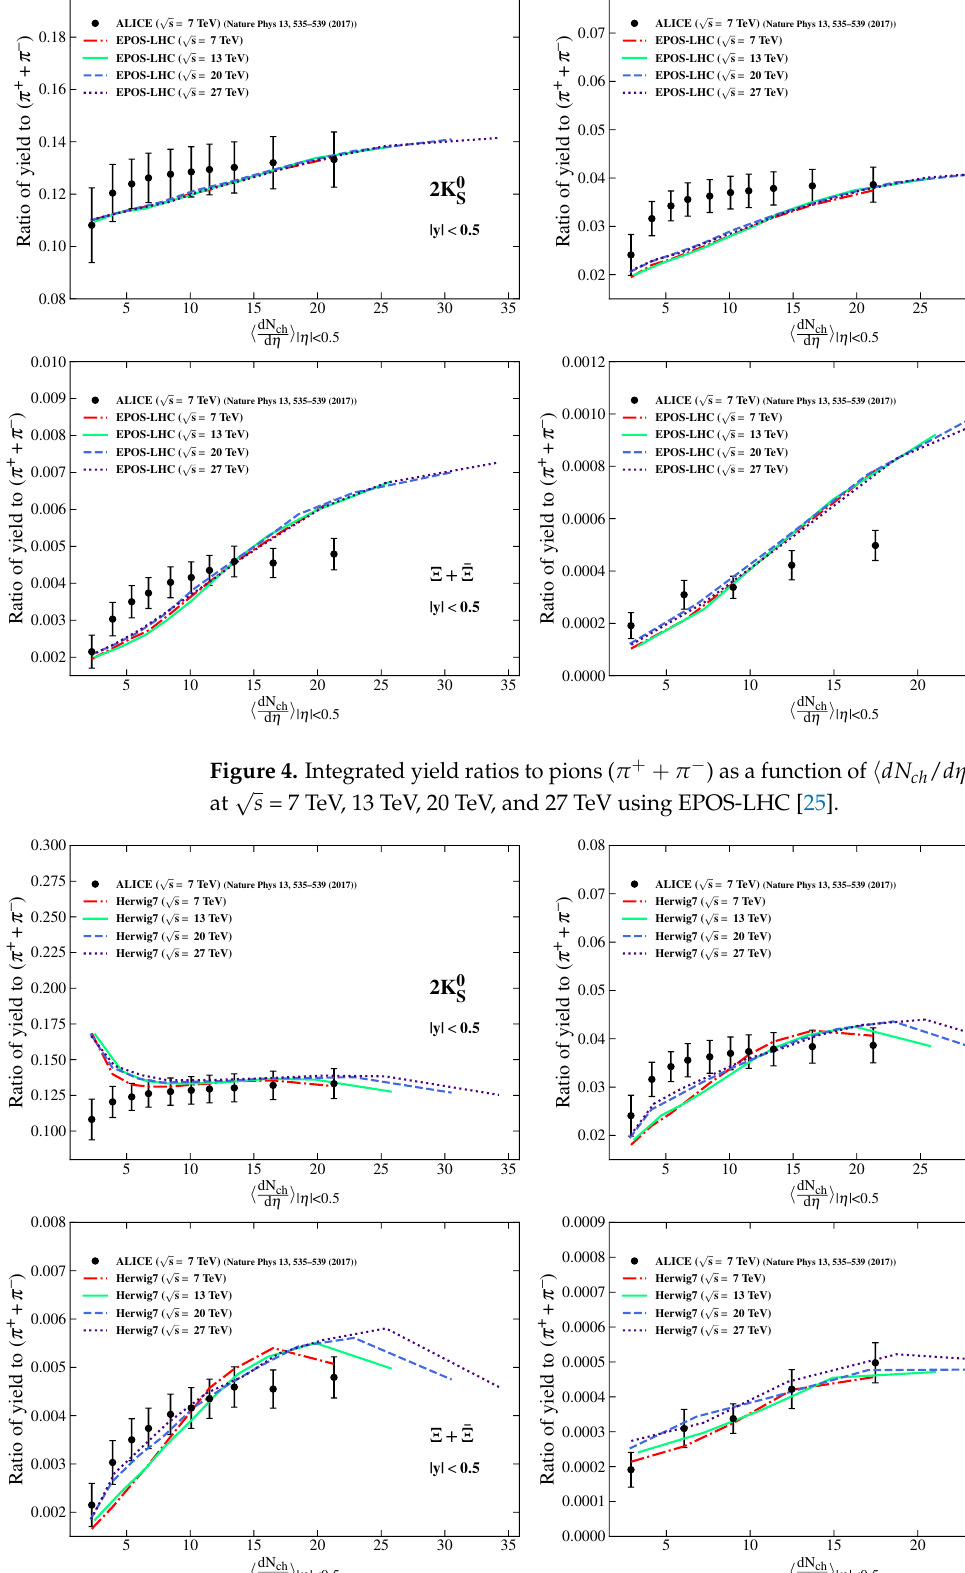
< 0.5 dN ch / d η y measured in (cid:104) (cid:105) | |